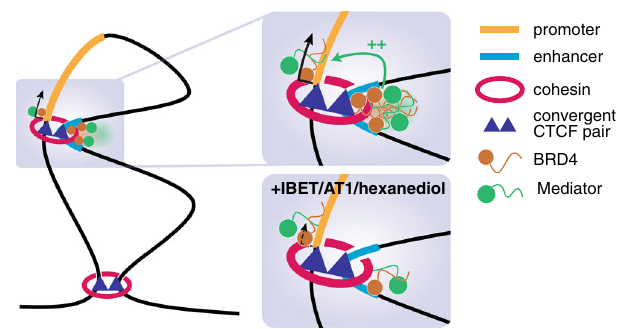
Fig. 6 Model for enhancer – promoter interaction. Higher-order chromatin boundaries are maintained by cohesin loops associated with convergent CTCF dimers. Within a domain, many enhancer – promoter contacts are associated with RAD21/CTCF peaks, and we suggest that similar cohesin loops are required for a subset of these interactions. At some enhancers (for example super-enhancers) a high concentration of factors such as BRD4 and Mediator drive the formation of phase condensates, and these may increase interactions with factors at the promoter, held nearby by cohesin loops. These interactions may be required to activate or increase transcription from the promoter. Upon addition of IBET, AT1, or 1,6- hexanediol, BRD4 and Mediator binding is reduced at the enhancer and phase condensates are dissolved, disrupting interaction with factors at the promoter. This disrupts gene expression, but does not affect enhancer – promoter proximity as the two loci remain held together by other factors, for example